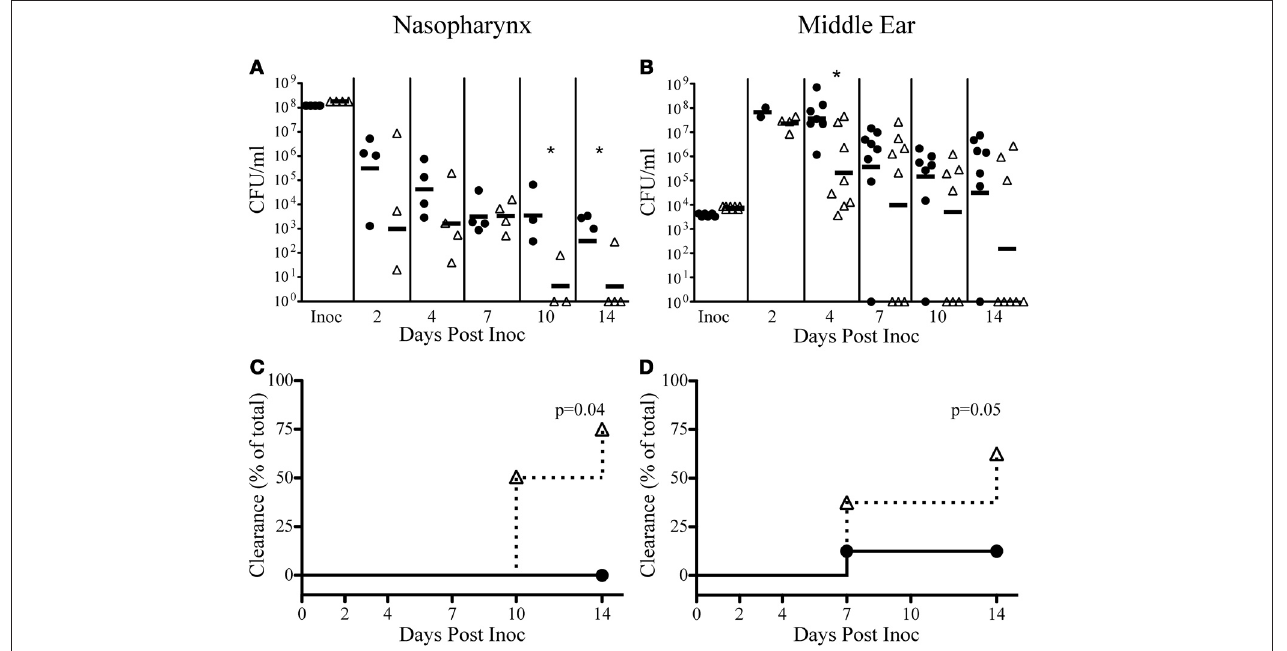
attenuated in the nasopharynx (days 10 and 14) and in the middle ear (day 4) and was cleared more rapidly from the nasopharynx (3 of 4 animals; A, C ) and the middle ear (4 of 7 ears; B, D ), compared to the parent strain (Chi square p = 0.04 and p = 0.05, respectively). Each cohort contained four animals [nasopharynx: n = 4; middle ear: n = 8 (left and right ears)]. *Denotes p < 0 . 05 by a two-tailed Mann–Whitney U